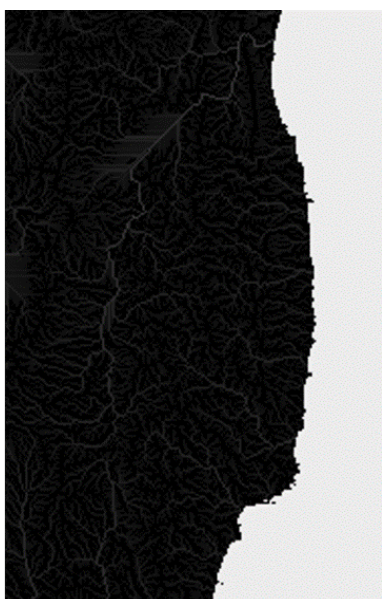
Figure 16. Runoff from rivers and groundwater